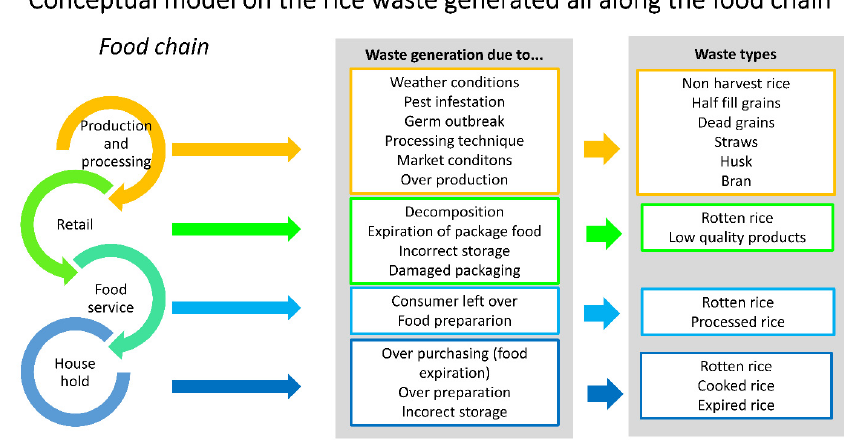
Figure 3. Conceptual model on the rice waste generated all along the food chain adopted from [42,43].